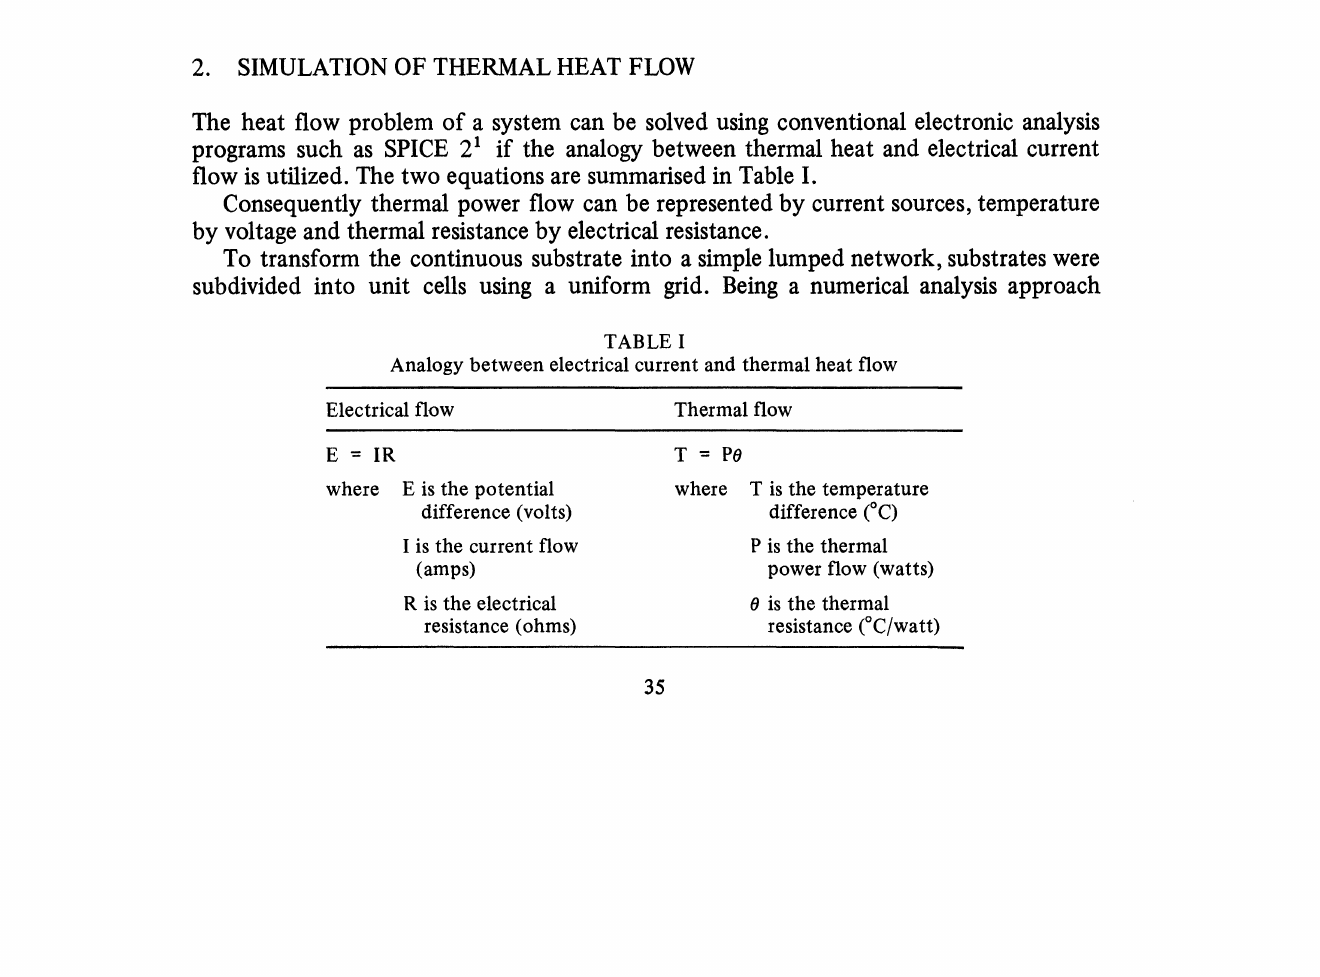
TABLE Analogy between electrical current and thermal heat